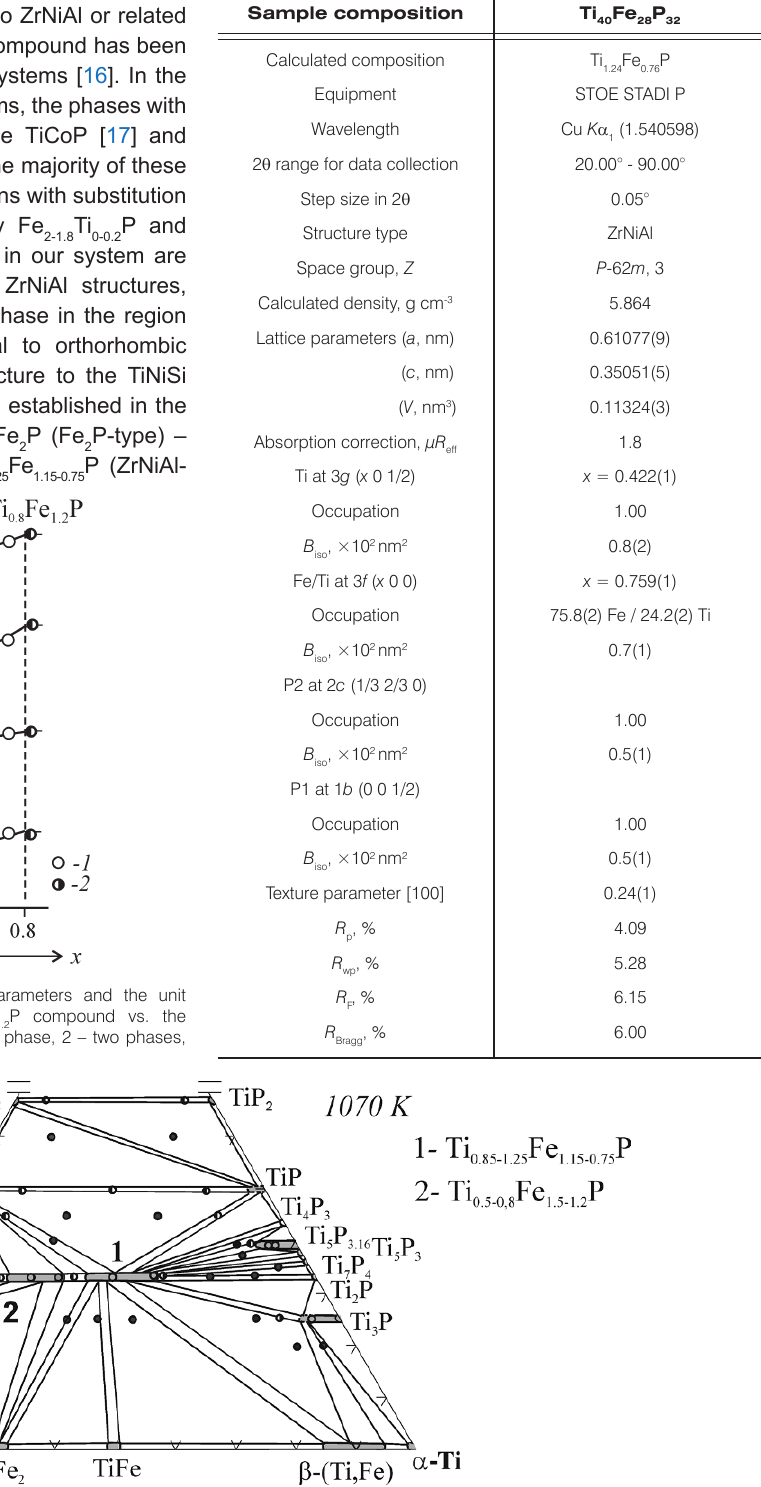
Fe P phase. 1.24 0.76